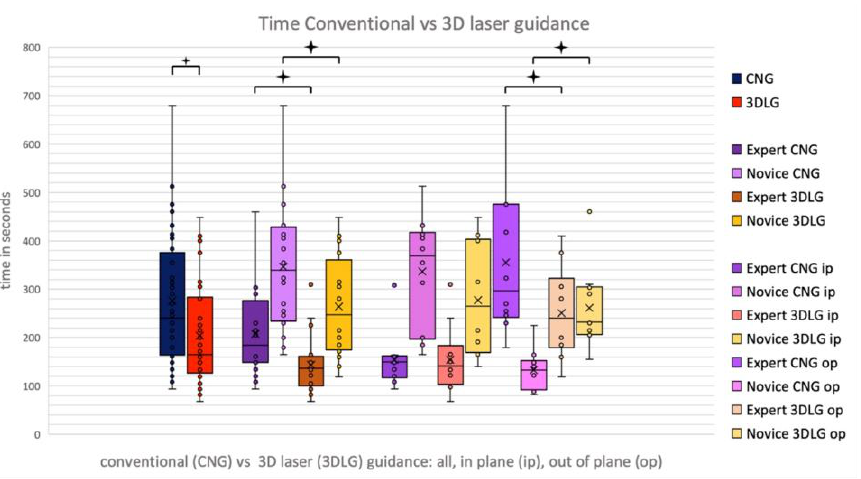
Figure 5. Procedural times for conventional needle guidance (CNG) and 3D laser guidance (3DLG), for expert and novice in in-plane and out-of-plane procedures.